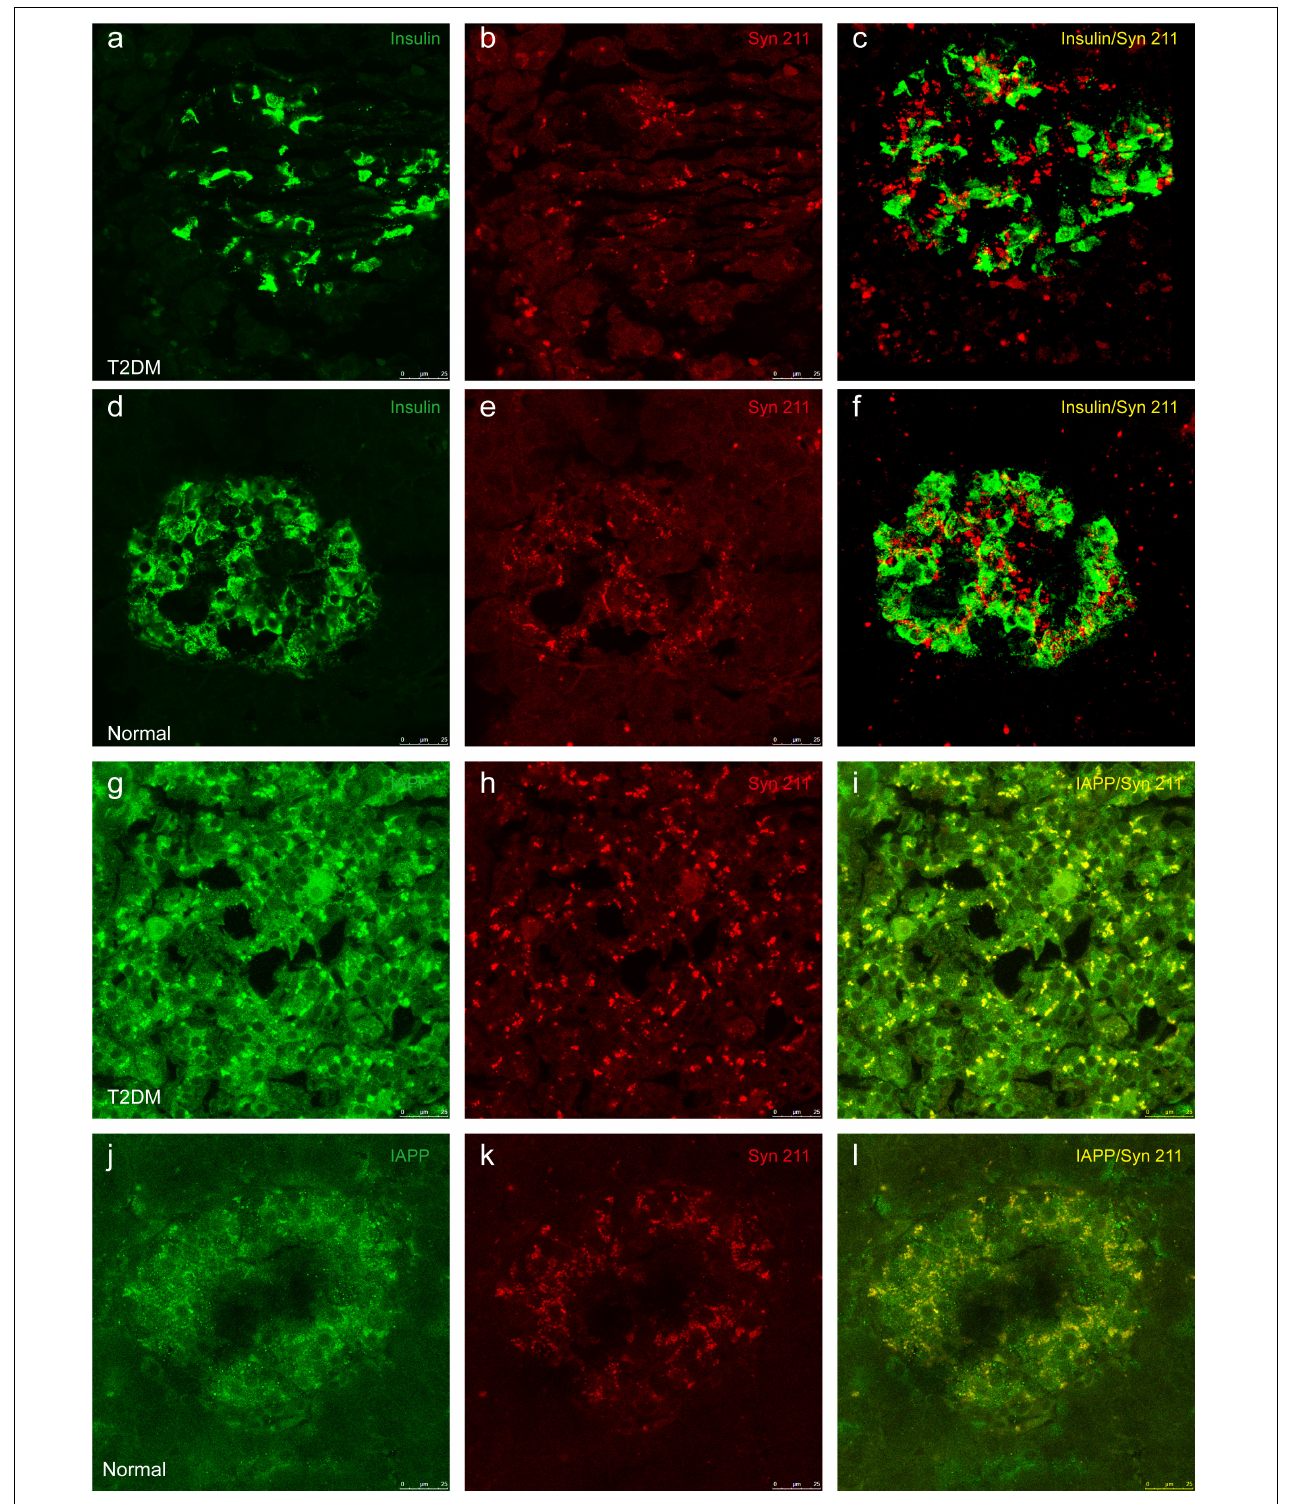
FIGURE 3 | Double immunofluorescence images showing the presence of α -synuclein in insulin-positive cells (a–f) and colocalization between α -synuclein and IAPP (g–l) . Dual immunofluorescence labeled for insulin (a,d) and α -synuclein (Syn 211) (b,e) exhibits partial overlapping of these two proteins in pancreatic β cells from a 20-year-old female diabetic monkey (ID: DM952044) (a–c) and from a 21-year-old normal female monkey (ID: N930840) (d–f) . IAPP (g,j) and α -synuclein (h,k) are highly co-localized to each other in a 20-year-old T2DM male (ID: DM942055) (g–i) and a 20-year-old normal female (ID: N942303) (j–l) . Scale bar = 25 µ m.